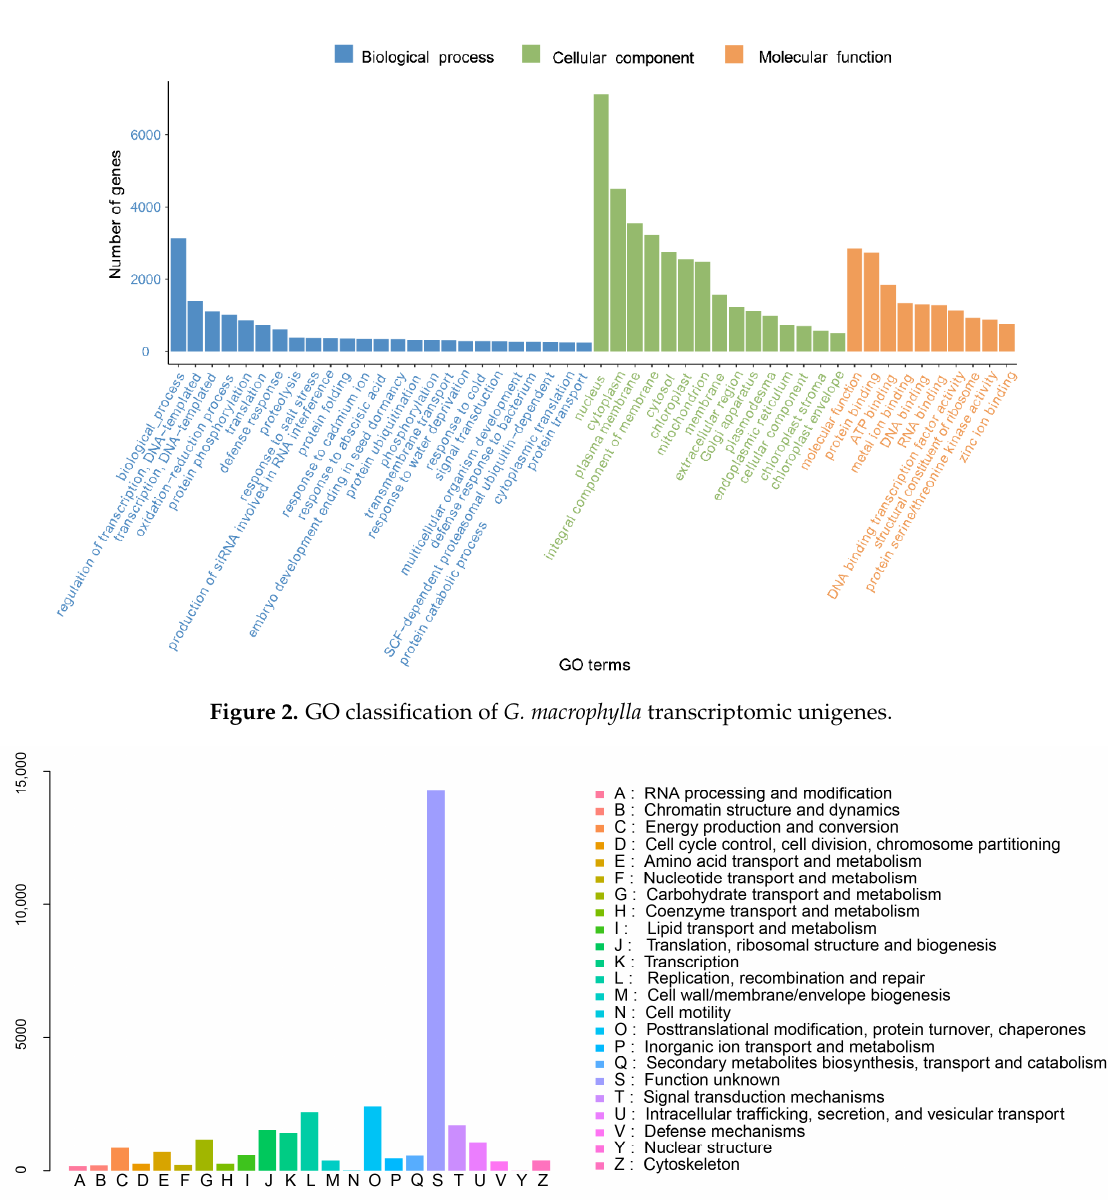
Figure 2. GO classification of G. macrophylla transcriptomic unigenes.